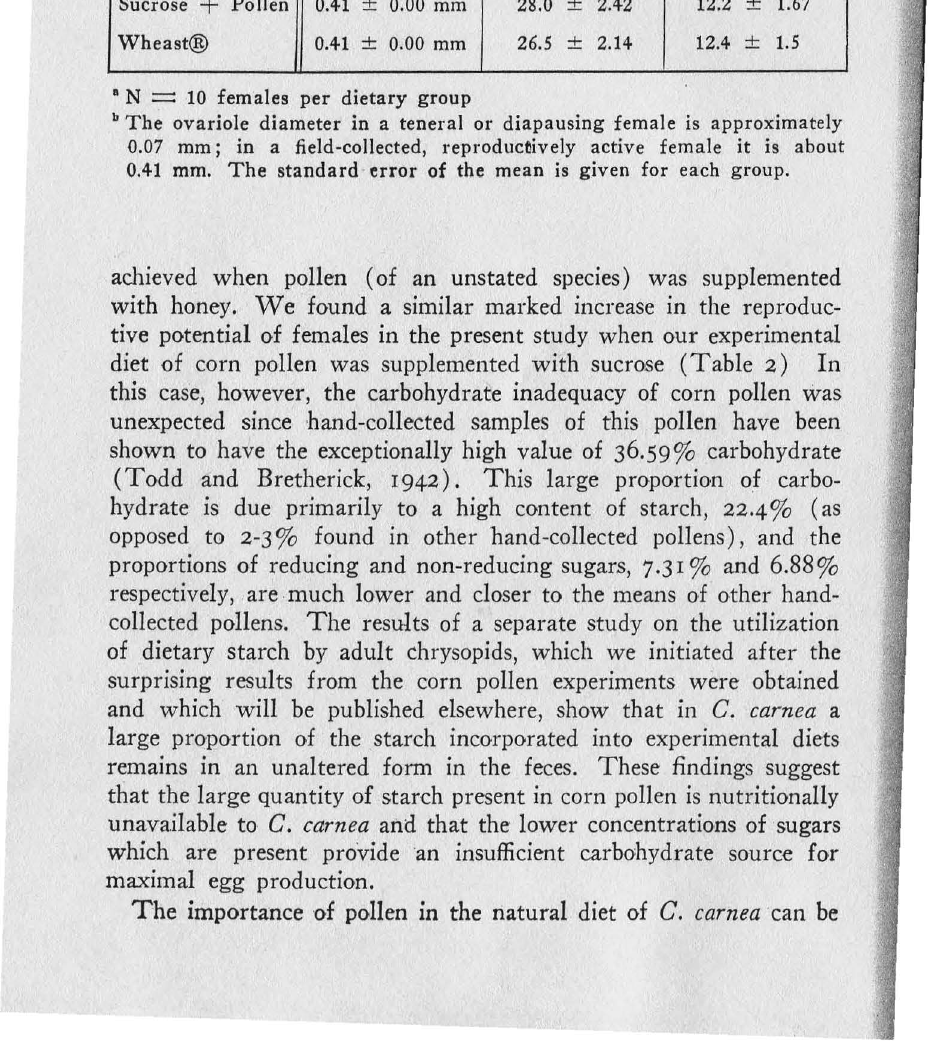
Table 2.- The effect of diet on the ·reproductive maturation o·f lab-reared · females of Chrysopa carnea.